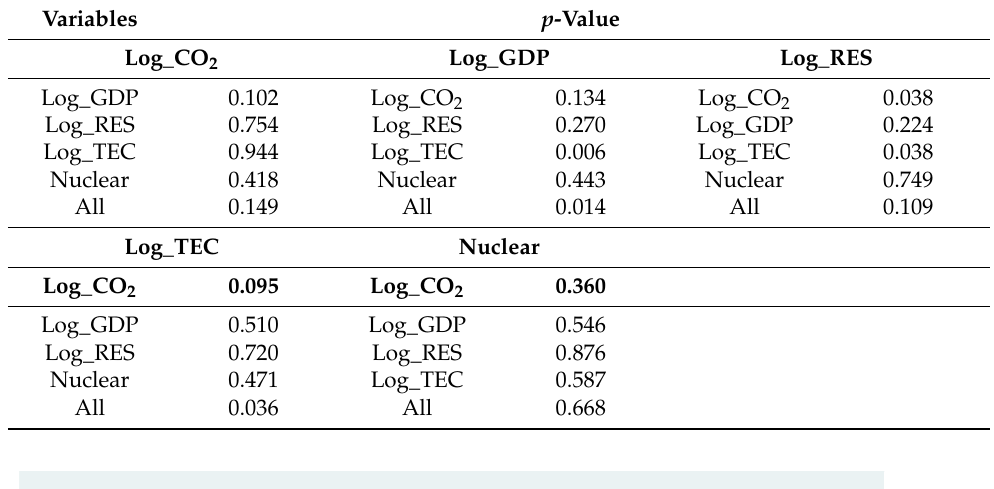
Table 7. Panel VAR Granger causality Wald test.